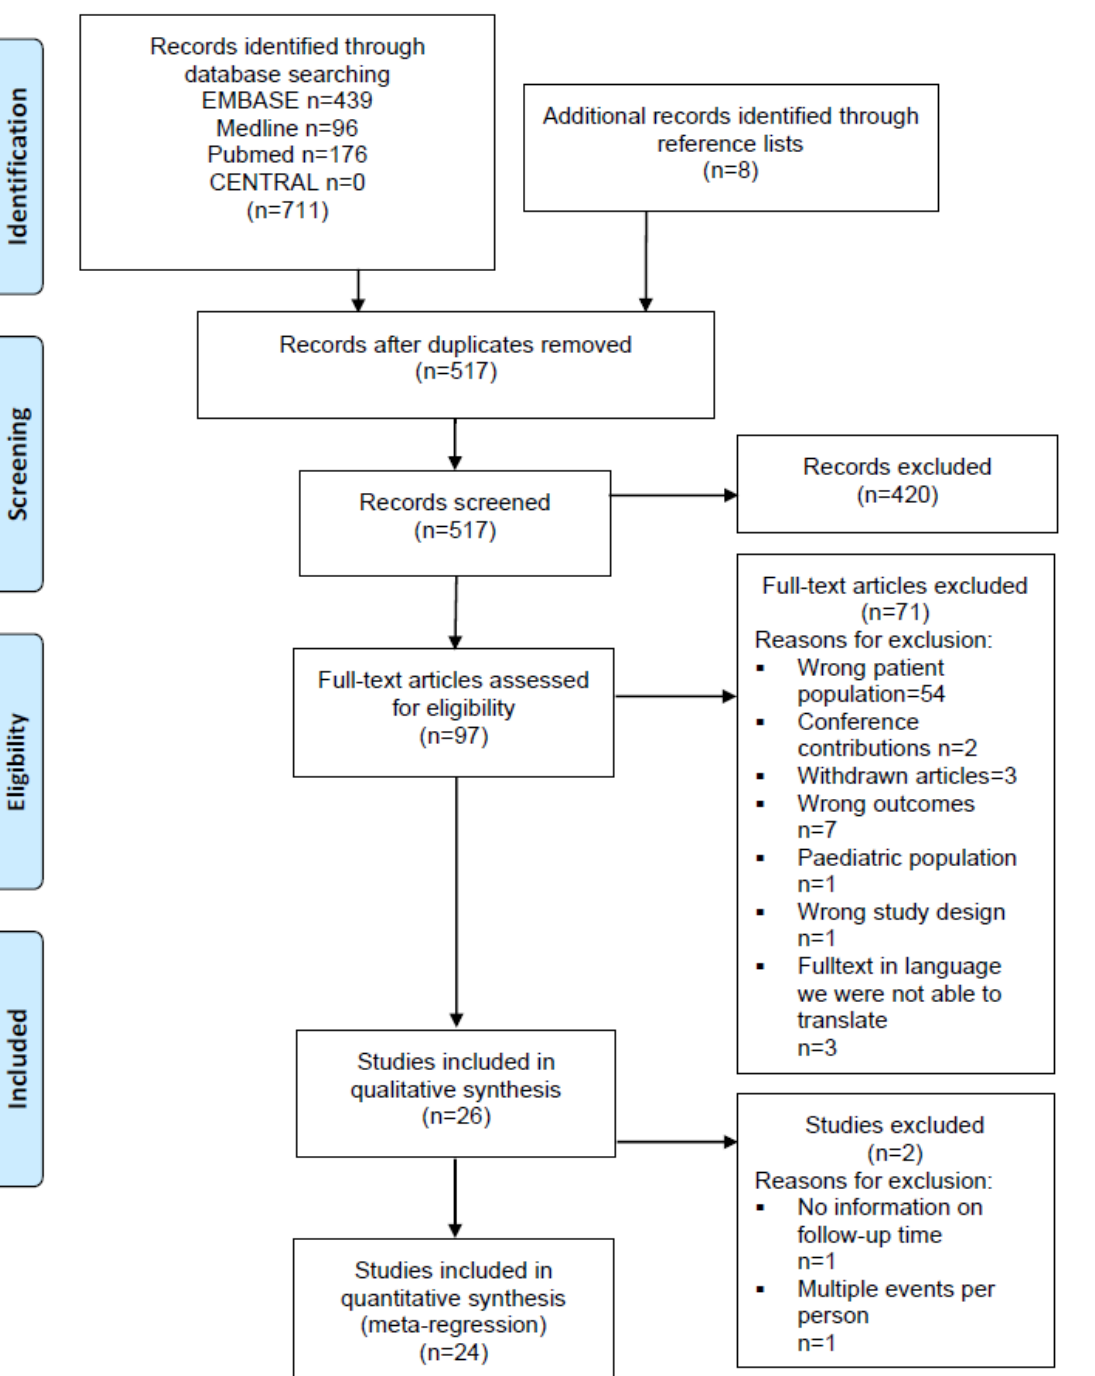
Figure 1. PRISMA flow diagram. Systematic review of incidence studies of pneumonia in persons with spinal cord injury.